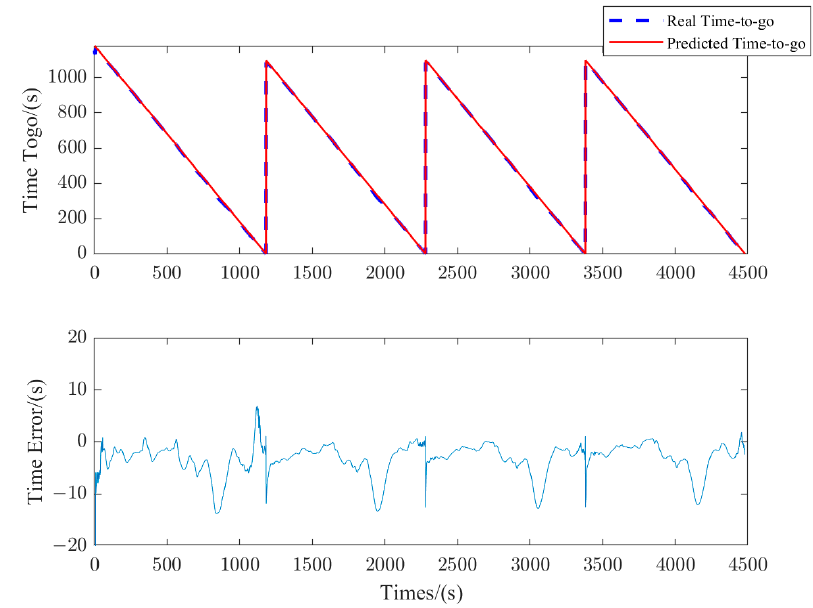
Figure 8. Test results of predicted time-to-go.